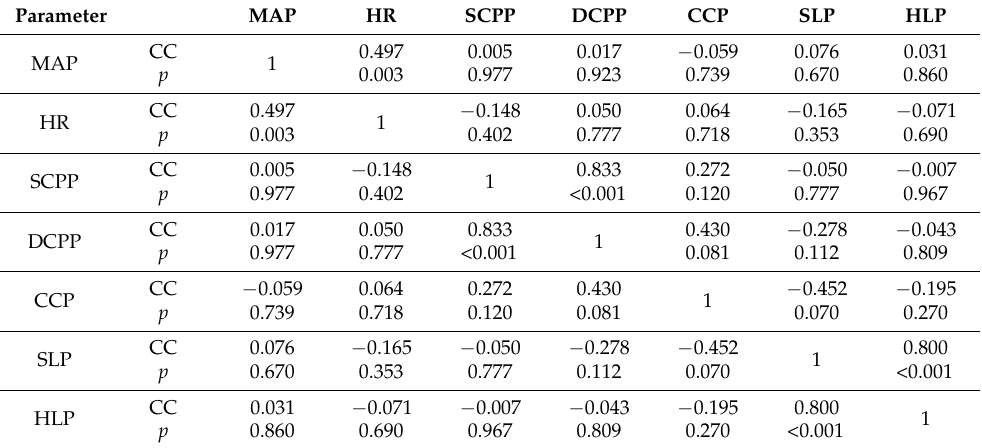
Table 4. Correlation analysis of changes in arterial pressure, heart rate, and ocular perfusion values due to isometric activity.